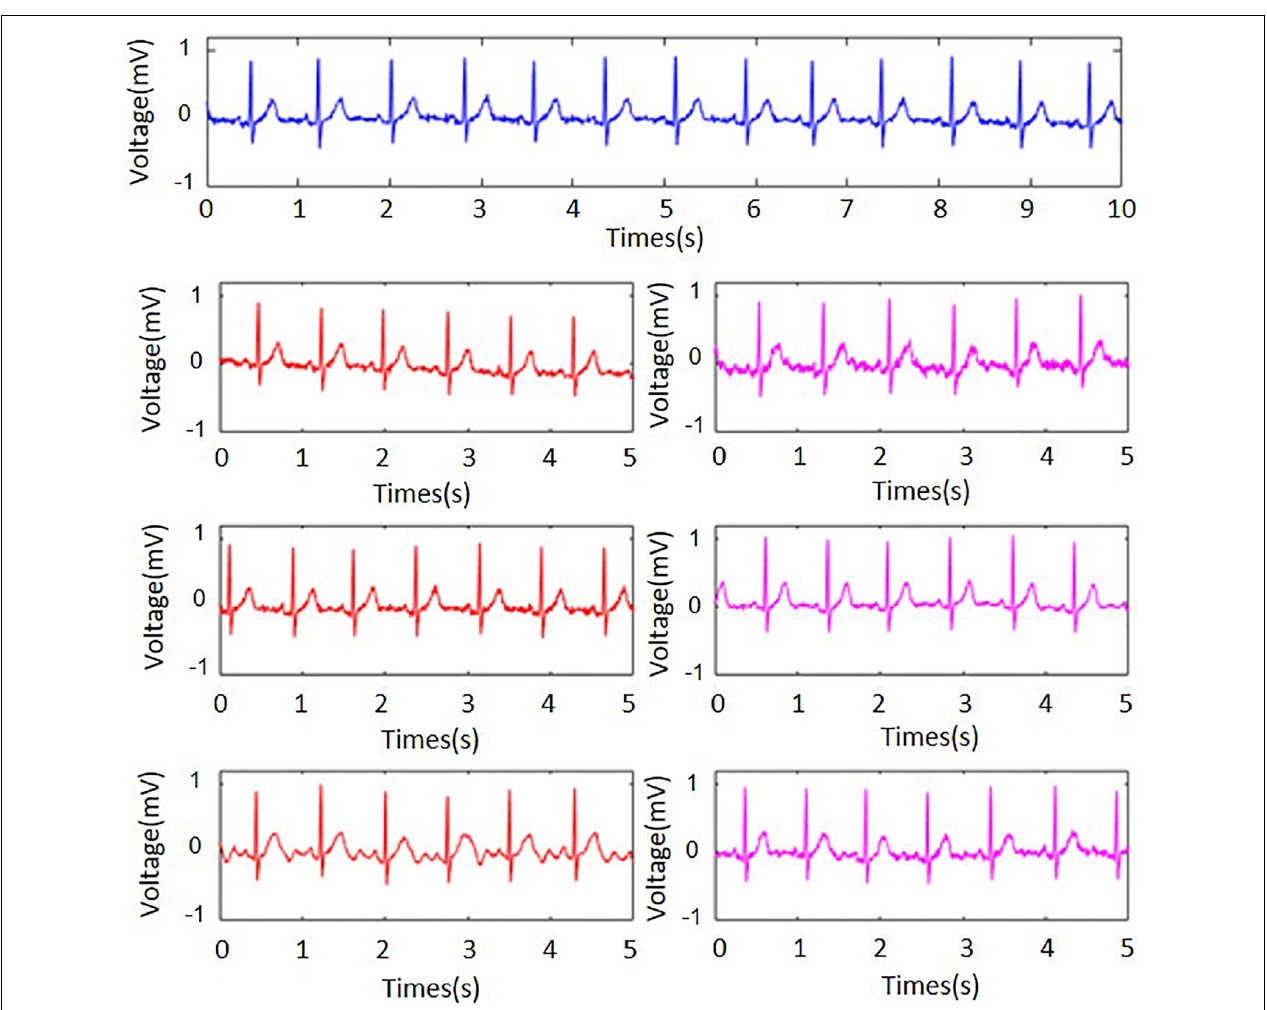
FIGURE 3 | Static electrocardiographic signals collected under different electrodes (blue for wet electrode, red and pink for flexible non-contact electrode) and under different thicknesses of canvas (red for a layer of canvas and pink for three layers). The second, third, and fourth rows used small, medium, and large electrodes,